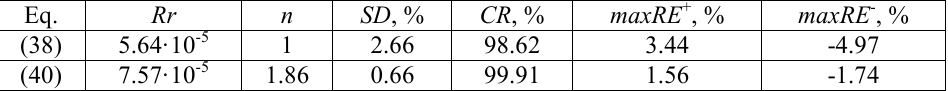
Table 7 Equivalent sandgrain roughness for database from [16]